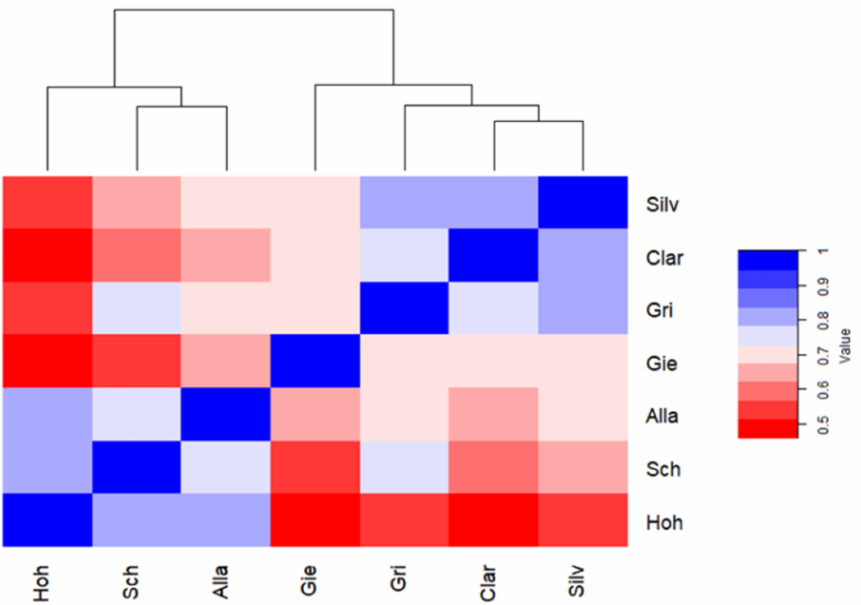
Figure 3. A heatmap representation of the Spearman correlation matrix of detrended B a and dendro- gram of similar groups of glaciers (group 1: Silvretta (Silv.), Clariden (Clar.), Gries (Gri.) and Gietro (Gie.); group 2: Allalin (Alla.), Schwarzberg (Sch.) and Hohlaub (Hoh.)). The right bar shows the color code of the correlation coefficients (all significant at p <